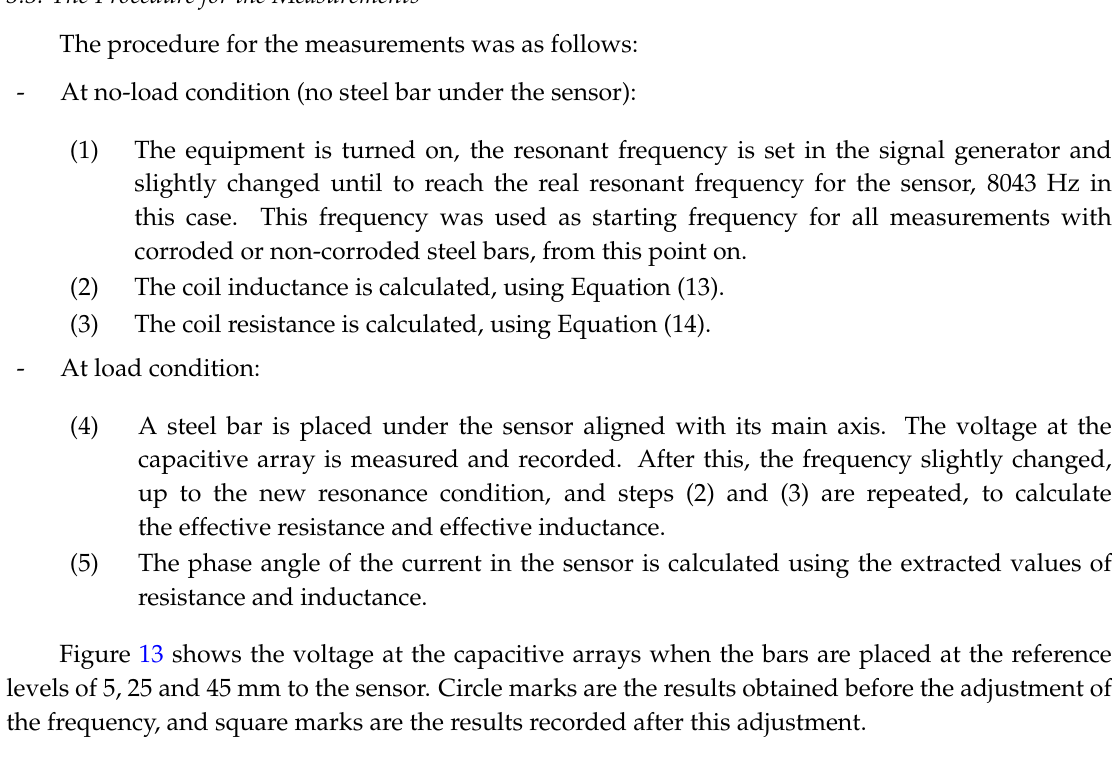
Figure 14. Voltage difference, as a function of the bar gauge, loss of mass and reference distance. Red curves—20 mm bar gauge. Blue curves—16.0 mm bar gauge, magenta curves—12.5 mm bar gauge and black curves—10.0 mm bar gauge. As can be seen, the differences between the values measured before and after the frequency adjustment become smaller, as the distance from the sensor increases. For a better understanding of the behavior of the sensor as a function of the bar gauge, corrosion level and distance from the bar to the sensor, Figure 14 shows the difference between the voltage at no load condition and the voltage with a steel bar under the sensor. As can be seen, these voltage differences are very well stratified,